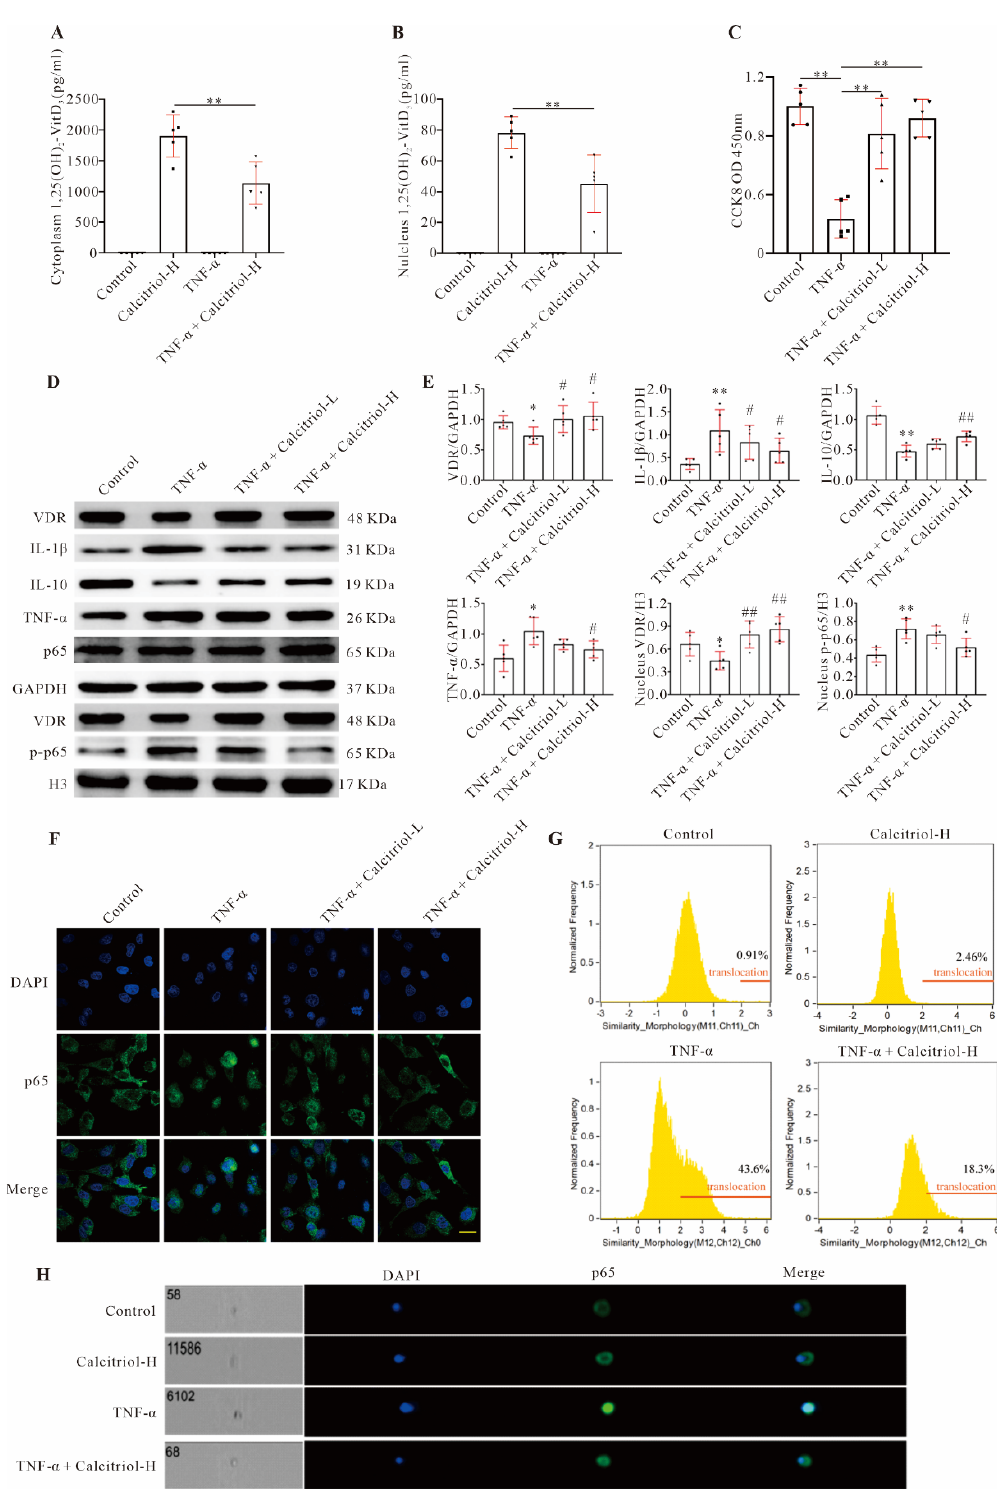
Figure 5. Calcitriol inhibited TNF- α -induced cardiomyocyte inflammation by preventing P65 nuclear translocation. ( A , B ) The cytoplasm ( A ) and nuclear ( B ) 1,25-OH Vitamin D 3 levels in TNF- α -treated AC16 cells ( n = 5). ( C ) CCK8 assay showed cell viability in AC16 cells exposed to 20 ng/mL TNF- α for 24 h in the absence or presence of different concentrations of calcitriol ( n = 5). ( D , E ) Western blot analysis of protein expressions in the whole-cell lysates (VDR, IL- 1β, IL -10, TNF- α, and NF - κB p65) or nuclear lysate (VDR and p-NF- κB p65) in AC16 cells with various treatments. Representative images ( D ) or quantitative analysis ( E ) from five experiments ( n = 5) were presented here. ( F ) Representative immunofluorescence staining analysis of p65 expression in AC16 cells. Scale bar represents 50 μm. ( G , H ) Imaging Flow Cytometer analysis of NF- κB p65 cellular locations in AC16